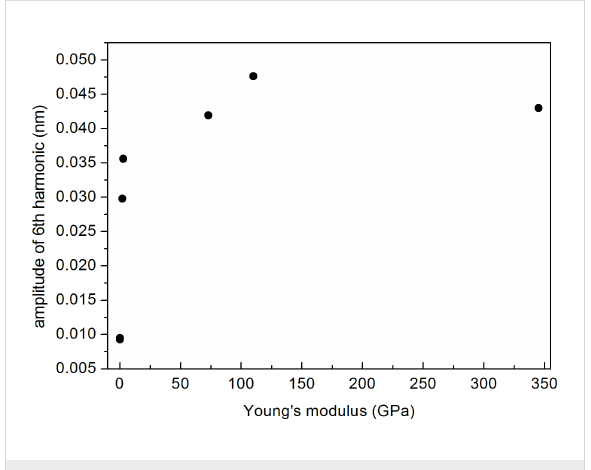
Figure 6: Experimental evolution of A 6 vs E for PDMS ( E = 0.0025 GPa), LDPE ( E = 0.1 GPa), PS ( E = 2.7 GPa), fused silica ( E = 72.9 GPa), titanium ( E = 110 GPa) and sapphire ( E = 345 GPa) using a 10.9 N/m